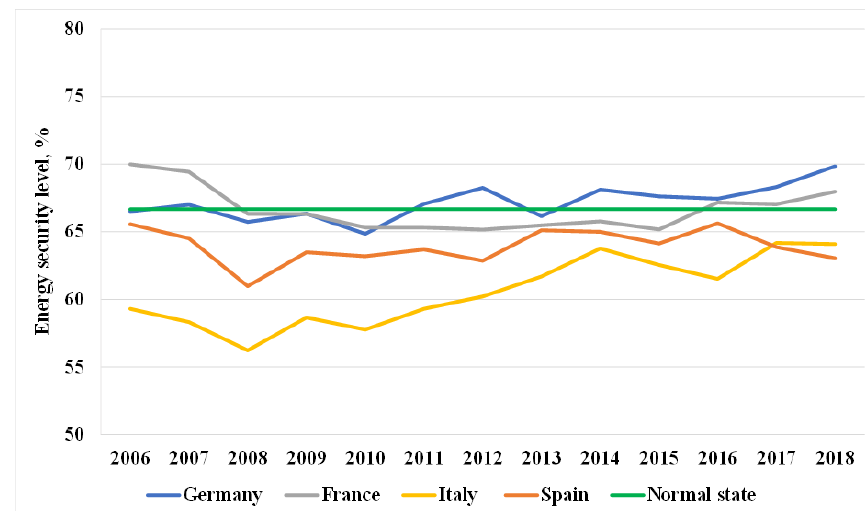
Figure 4. The dynamics of energy security levels in analyzed countries. Source: own research.